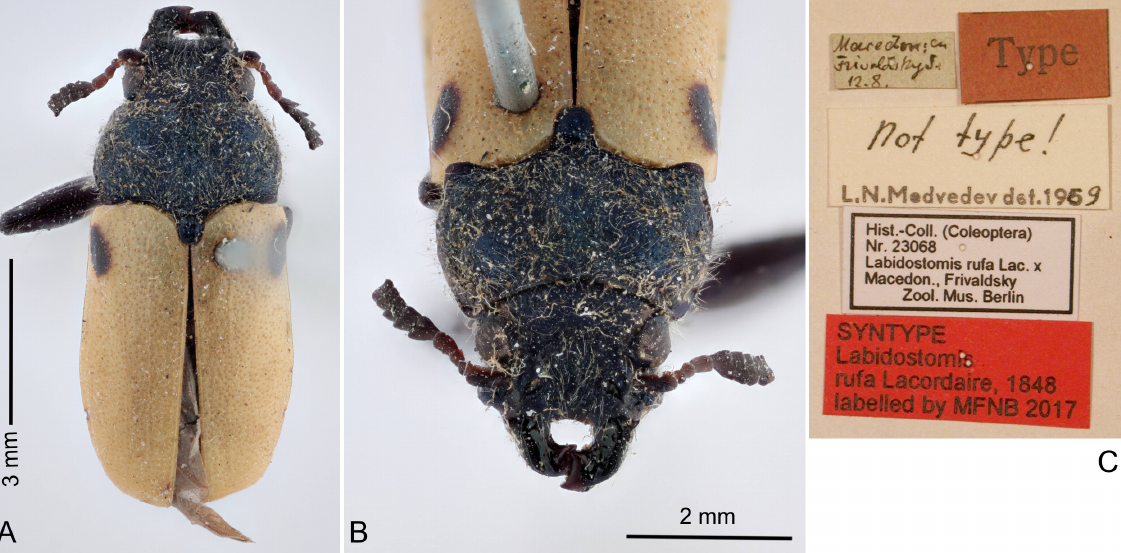
Fig. 3. Labidostomis rufa (Waltl, 1838), syntype of Clythra ( Labidostomis ) rufa Lacordaire, 1848, ♂, 9.0 mm (ZMHB). A . Dorsal view. B . Frontal view. C .